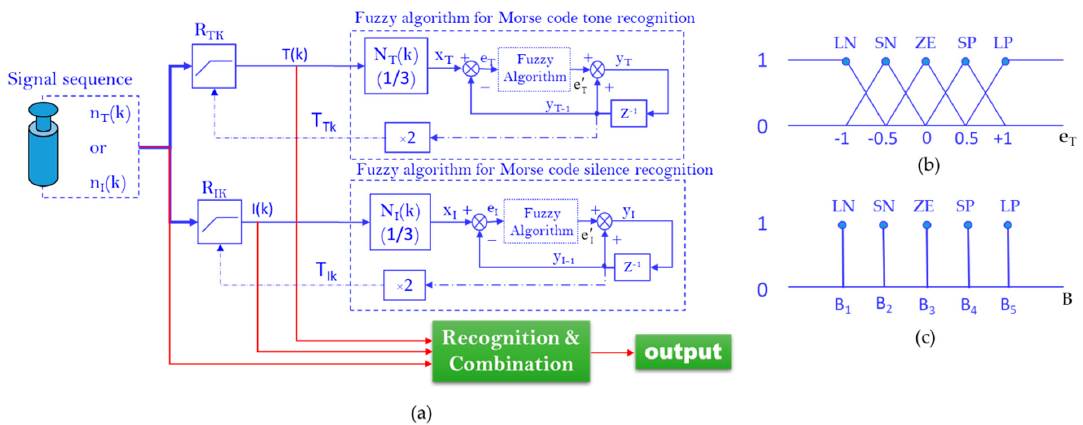
Figure 4. Fuzzy recognition algorithm of MCT for a single switch, ( a ) the flow chart of fuzzy Morse codes recognition in MCT; ( b ) the membership function of fuzzification; ( c ) the membership function of defuzzification.